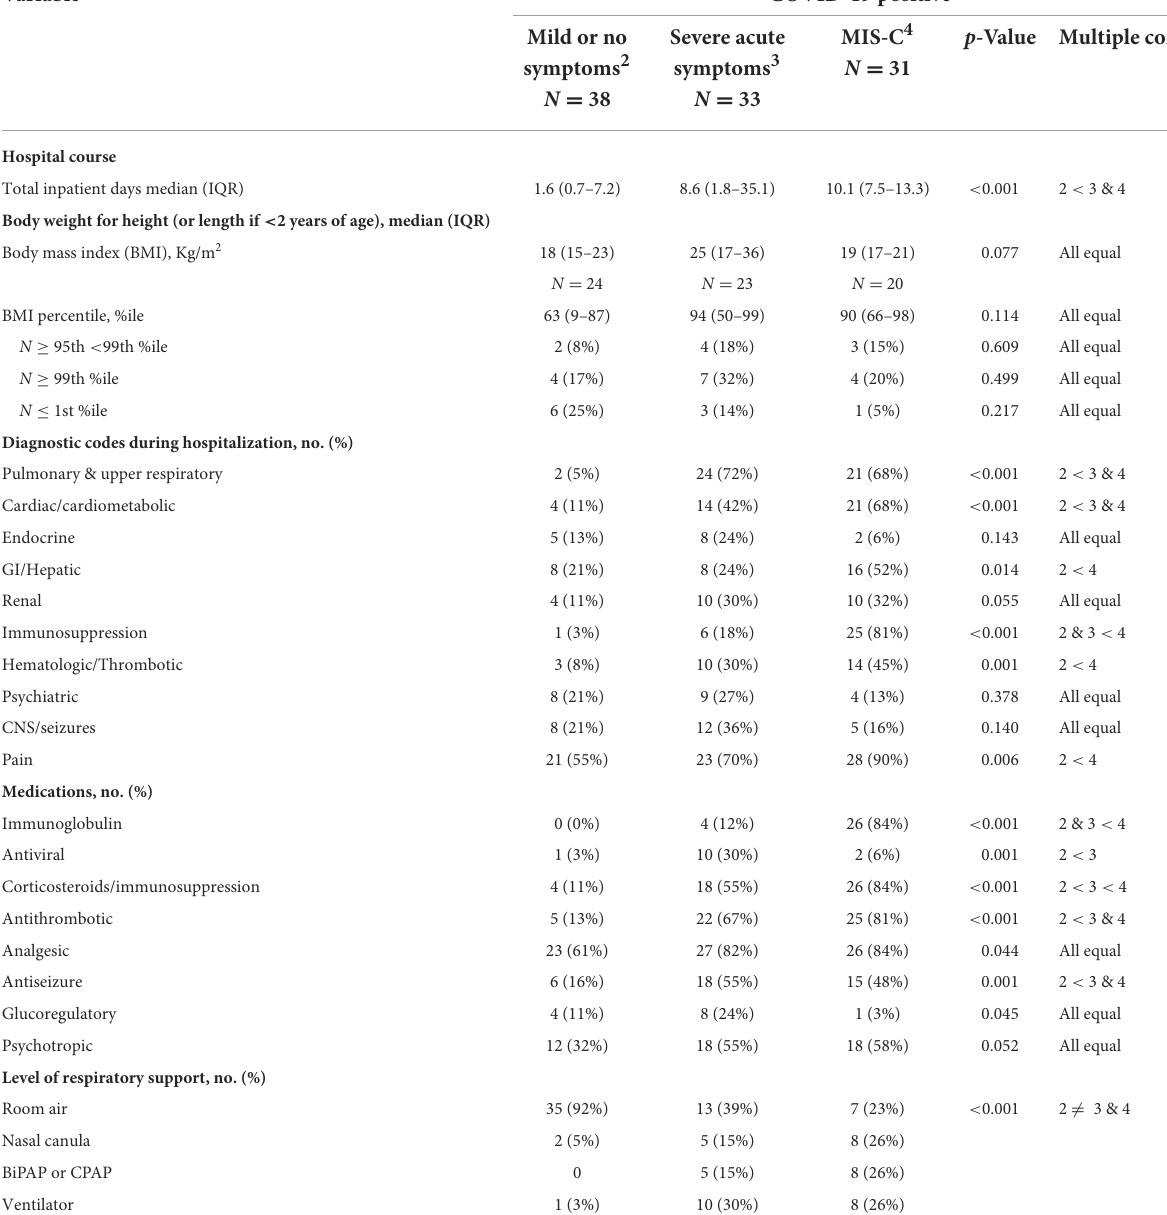
TABLE 2A Features of the hospital course for patients with